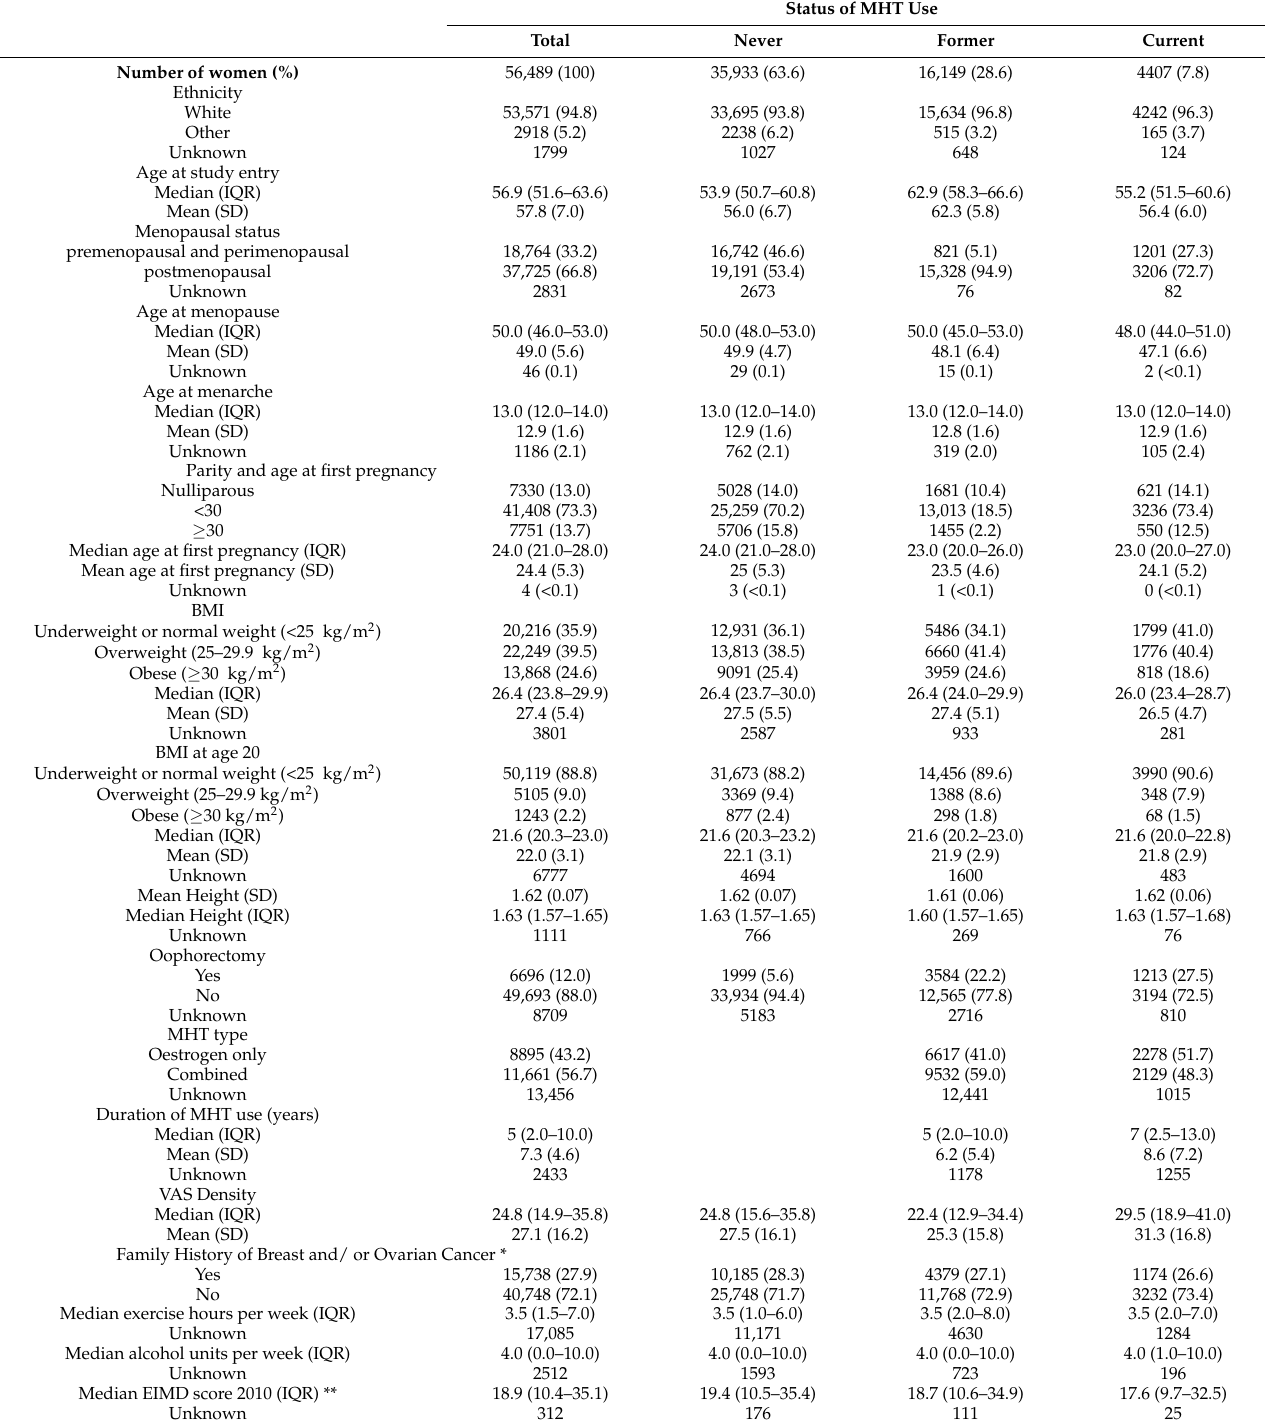
Table 4. Baseline Characteristics of the 56,489 women in the PROCAS cohort